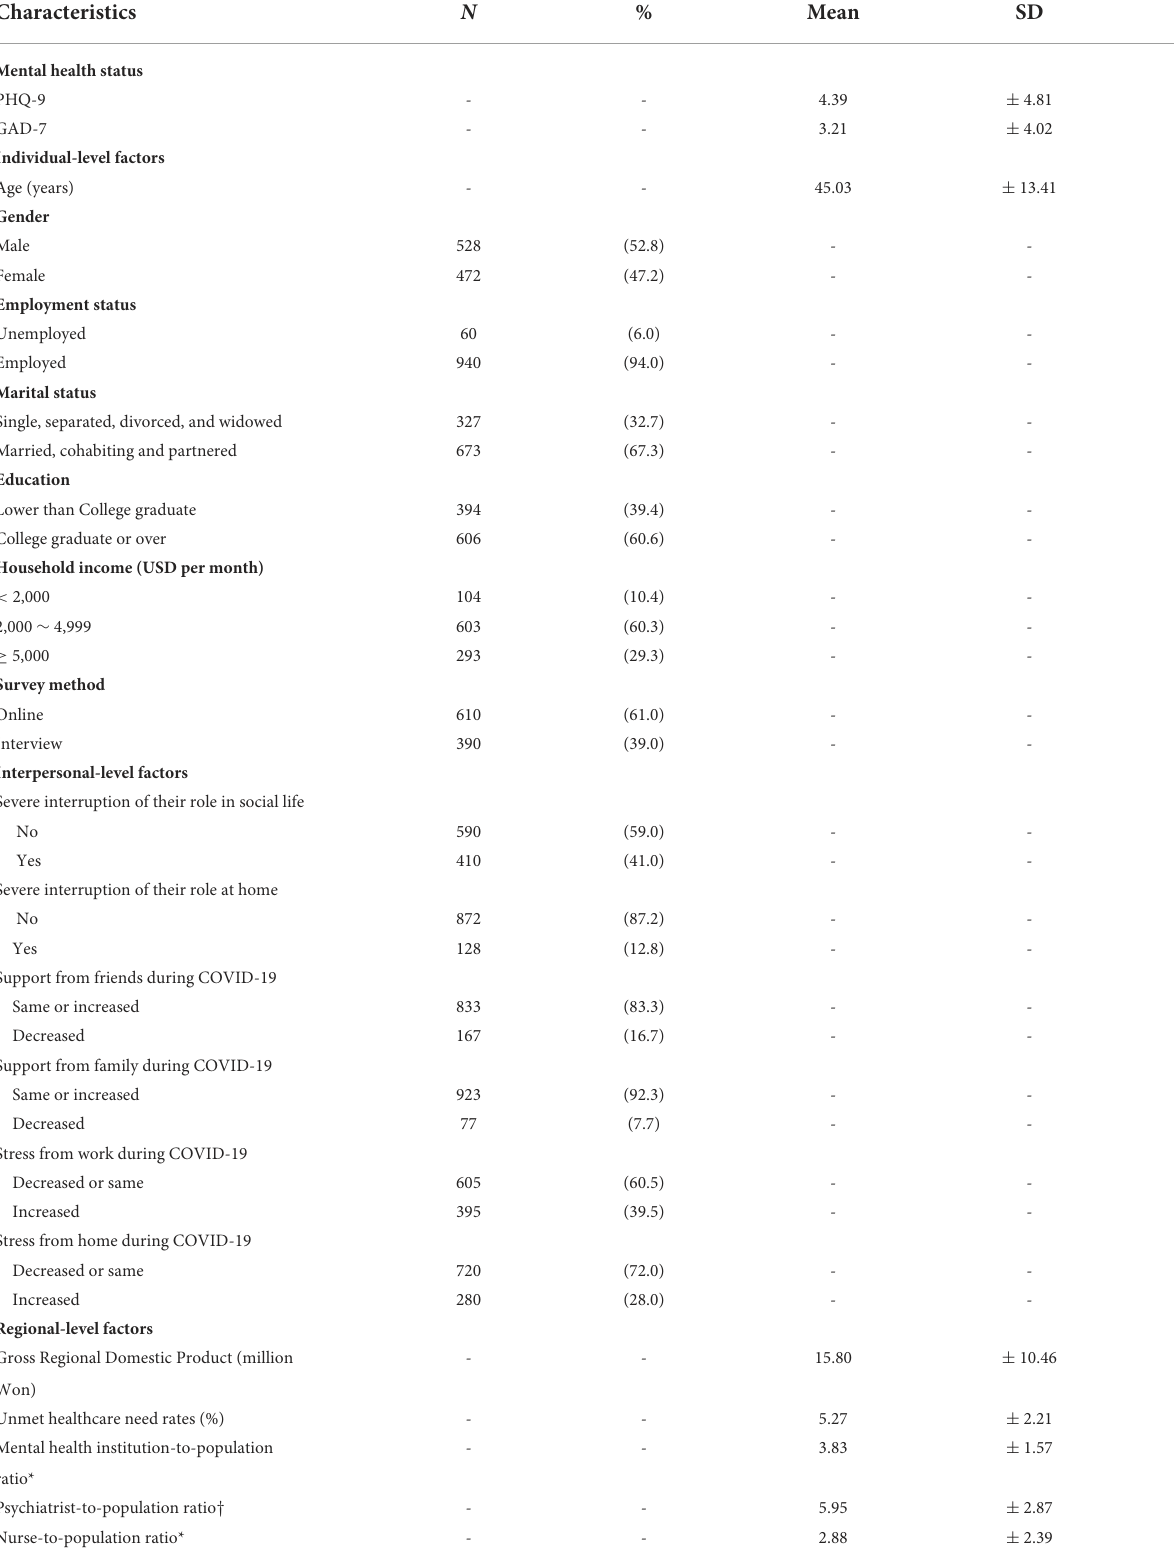
TABLE 1 Descriptive statistics of all variables in the analysis ( N =